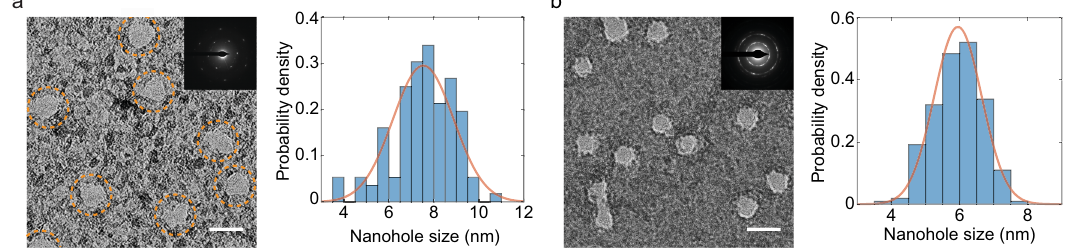
Fig. 1| Creationofnanoholesin suspended GO.a , b TEMimagesand normalized poresizedistributionsofsuspendedGOspecimensirradiatedwith710MeVBiions: a single-layer GO, ion fl uence of 2×10 11 ionscm − 2 , b 3 – 4-layer GO, ion fl uence of 4×10 11 ionscm − 2 . Insets show the corresponding selected area electron diffraction